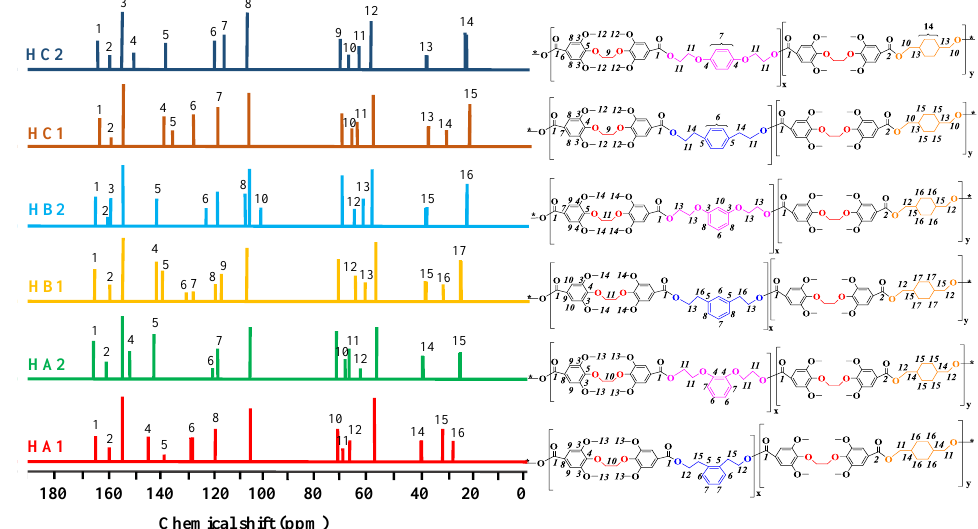
Figure 7. 13 C NMR spectra for poly(ether-ester)s .